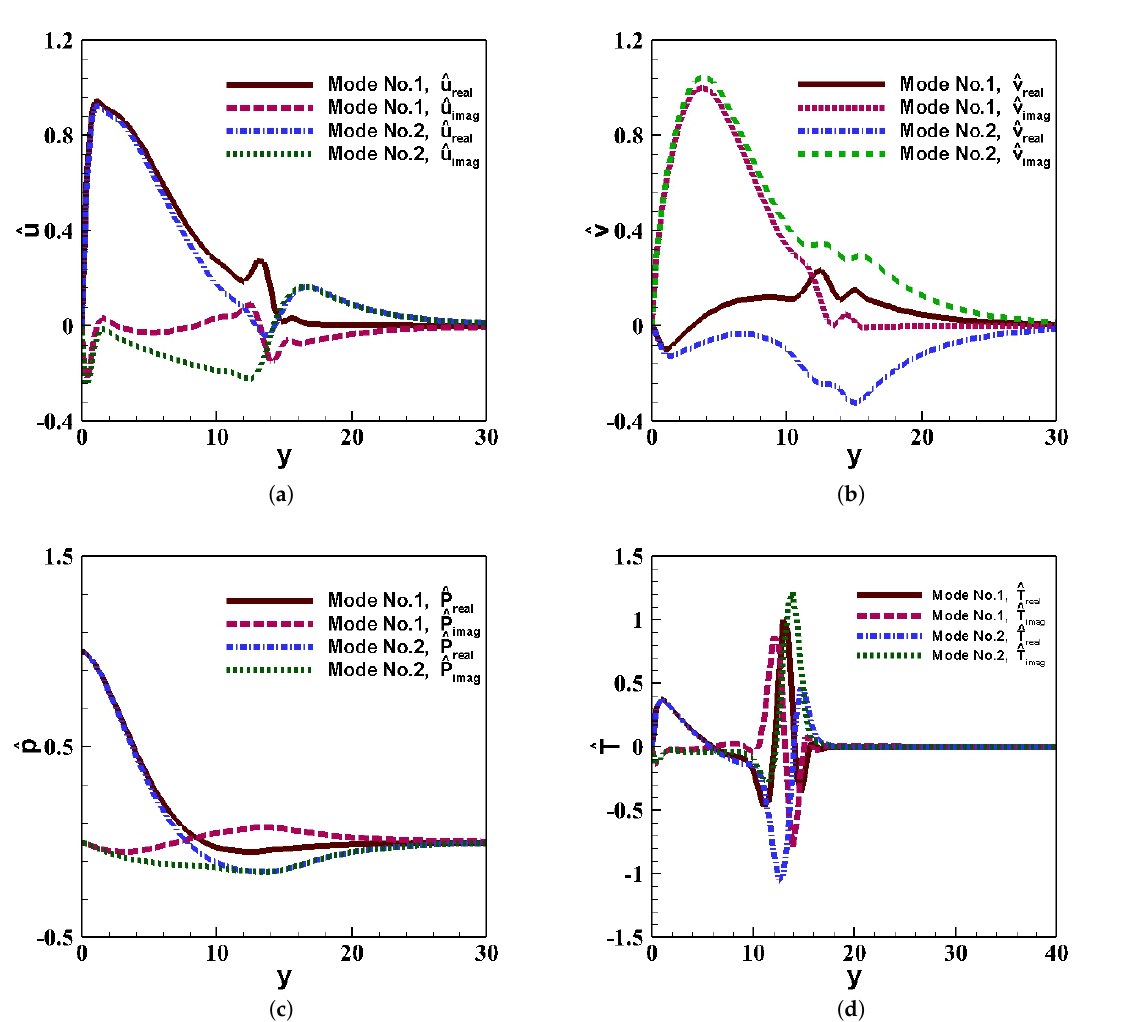
Figure 4. The stable and unstable modes related eigenvectors, with slip B.C.s. Ma e = 4.5, x ∗ = 0.139 m, and R = 1000.152.( a ) ˆ u ; ( b ) ˆ v ; ( c ) ˆ p ; ( d ) ˆ T